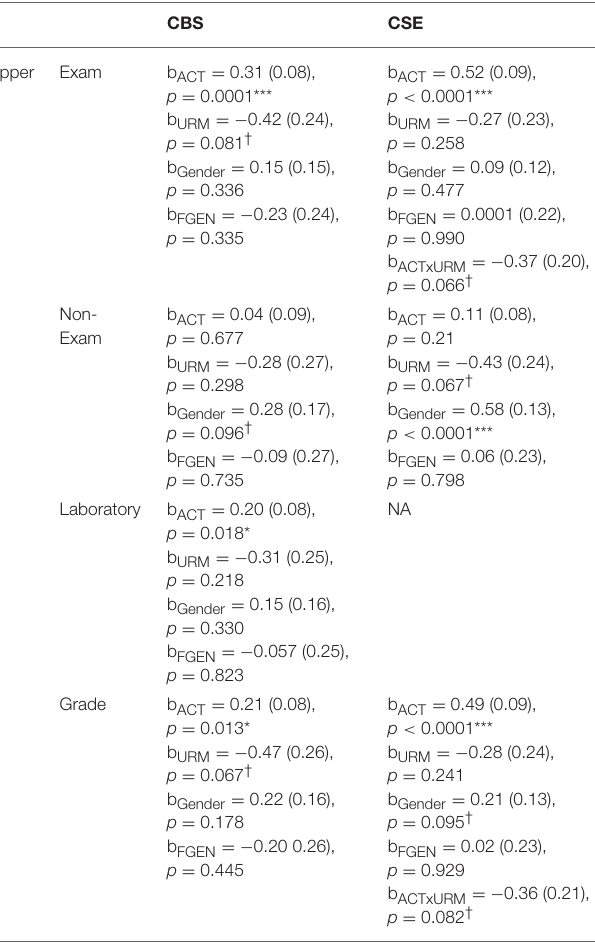
TABLE 7 | Predictors of performance in upper division courses across different assessment methods in the College of Biological Sciences (CBS) and the College of Science and Engineering